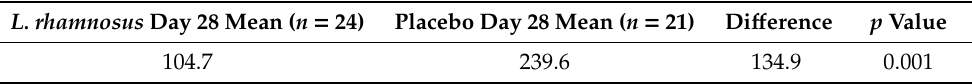
Table 3. Comparison of crying and fussing time (mean minutes per day) between the mean of L. rhamnosus Day 28 and the mean of placebo Day 28.